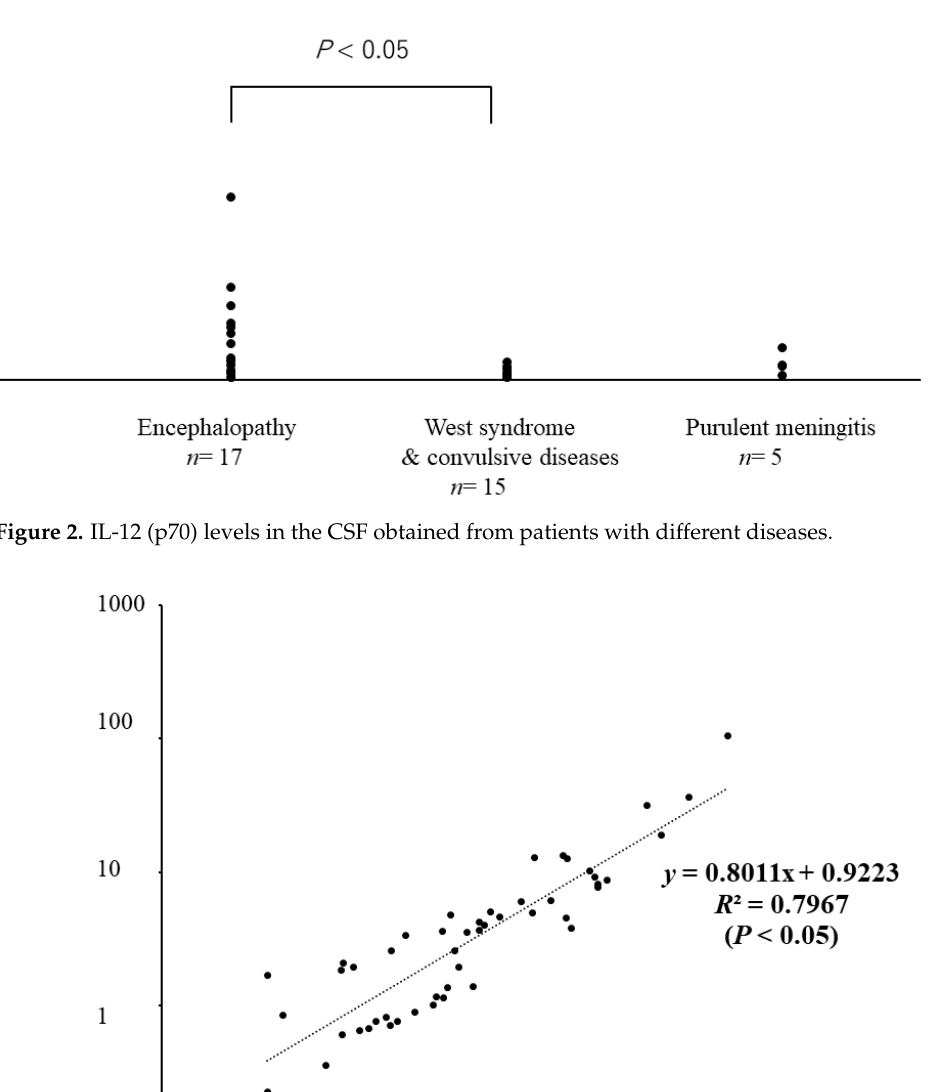
Figure 3. IL12 (p70) and VEGF levels in cerebrospinal fluid obtained from all patients.